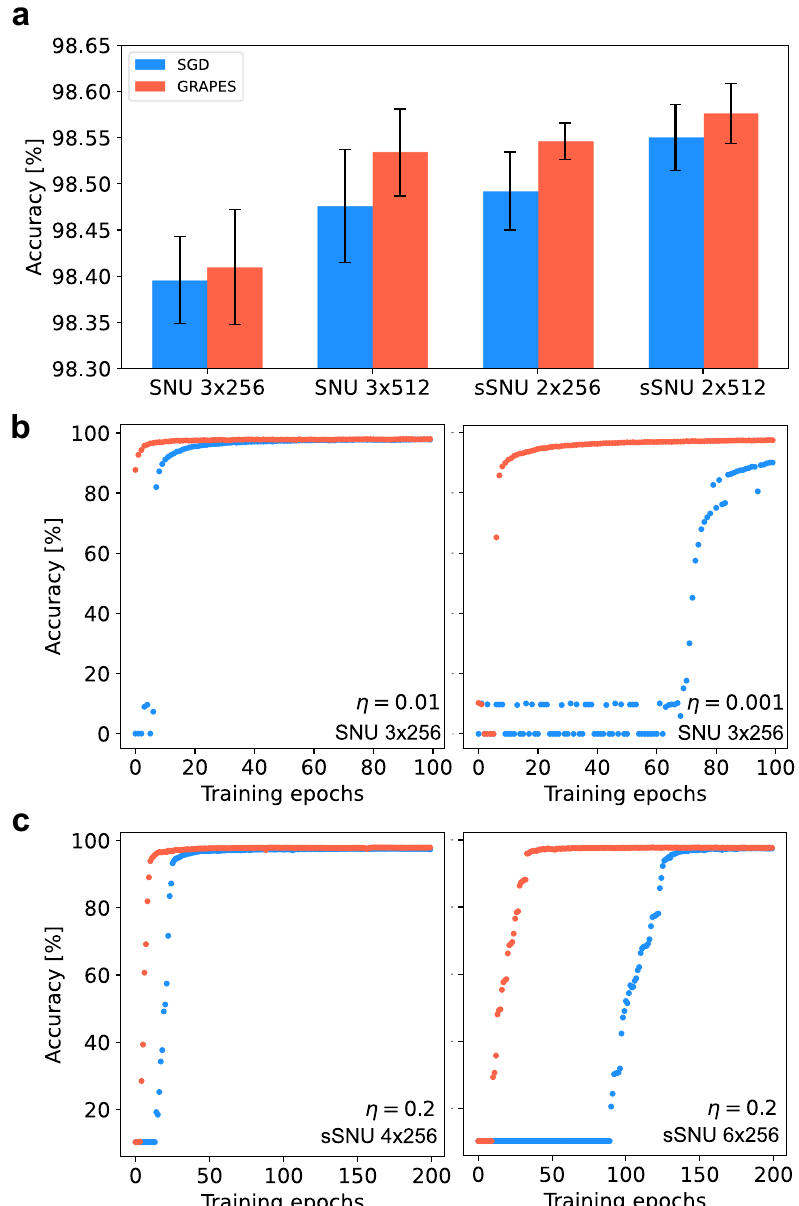
Fig. 7 Experiments with spiking neural networks. a Test accuracy for SNU and sSNU networks with three and two hidden layers, respectively. The results are mean and standard deviation of the test accuracy after training over fi ve independent runs. b Test curves for SNU 3 × 256 networks with decreasing values for the learning rate η . Left hand-side: η = 0.01. Right hand-side: η = 0.001. The initial 100 training epochs are shown. c Test curves for sSNU networks with increasing number of hidden layers. Left hand-side: 4 × 256 networks. Right hand-side: 6 × 256 networks. In ( b ) and ( c ) the curves correspond to a single